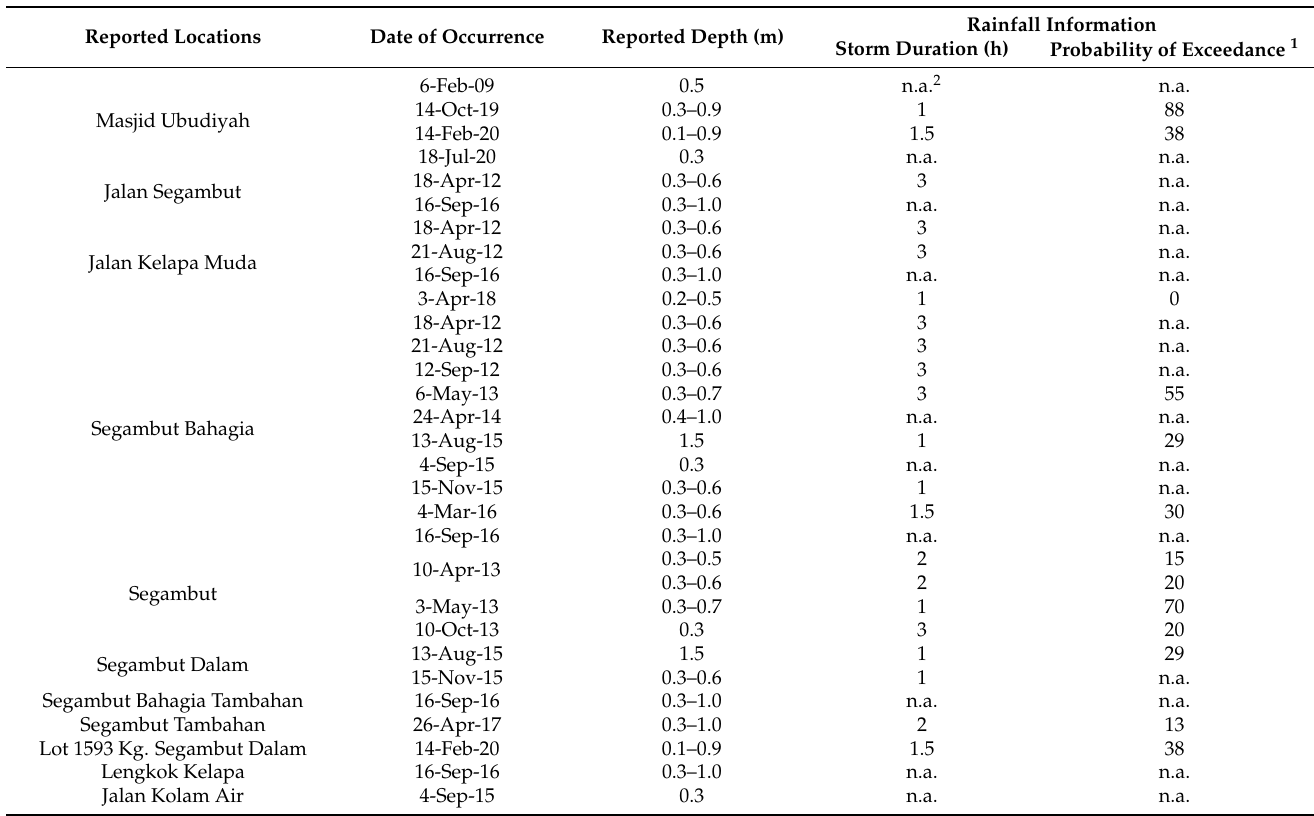
Table 1. Reported flood occurrences in Segambut